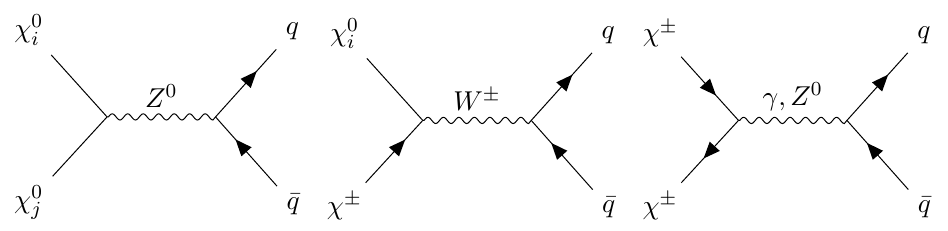
Figure 13 . Dominant co-annihilation processes for the case of doublet-dominated fermionic dark matter. The indices i, j = 1 , 2 run over the different neutral fermion states involved in the co-